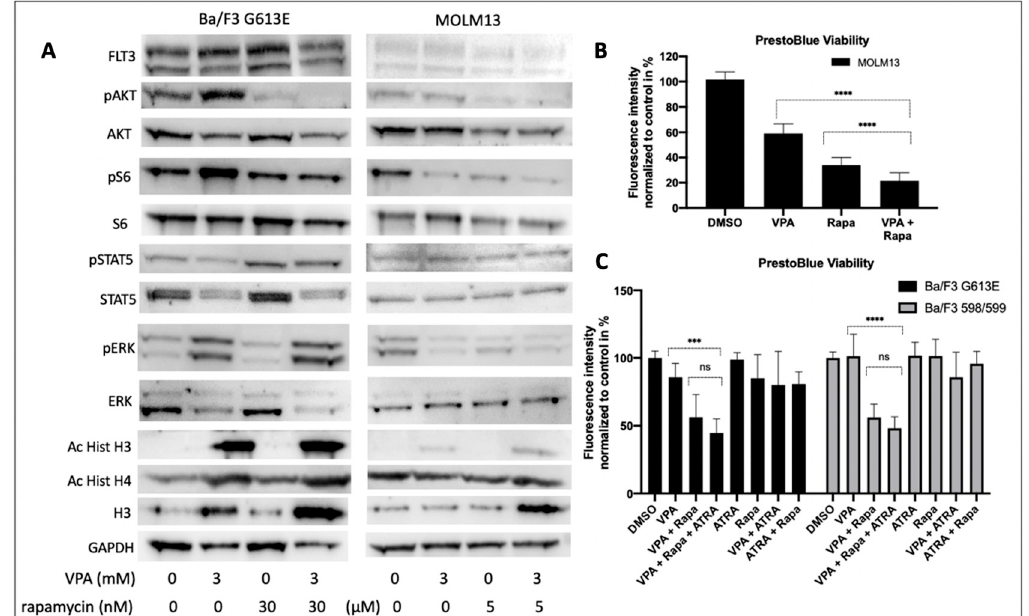
Figure 6. Induction of VPA and rapamycin on FLT3-ITD the downstream signaling and cell viability in Ba/F3 G613E and MOLM13 cells. Ba/F3 cells that were stably expressing FLT3-ITD G613E variant or MOLM13 cells were treated with 3 mM VPA alone, either 30 nM (Ba/F3) or 5 nM (MOLM13) rapamycin or a combination of both compounds as indicated. ( A ) The cell lysates were subjected to SDS-PAGE to analyze expression and phosphorylation status of signaling proteins. For the loading control, the levels of GAPDH were detected. The representative blots of two independent experiments are shown. ( B ) MOLM13 cells were incubated with VPA and/or rapamycin as indicated prior to viability analysis by PrestoBlue assay. ( C ) Ba/F3 cells that were either expressing the 598/599 or the G613E variant were incubated with VPA and/or rapamycin as indicated with or without 1 mM ATRA. the cell viability analyses were performed by PrestoBlue assay. The graphs are shown as mean ± SD from three independent experiments. Student’s t -test was used for calculating the statistical significance (**** p < 0.0001, *** p < 0.001, ns not significant)